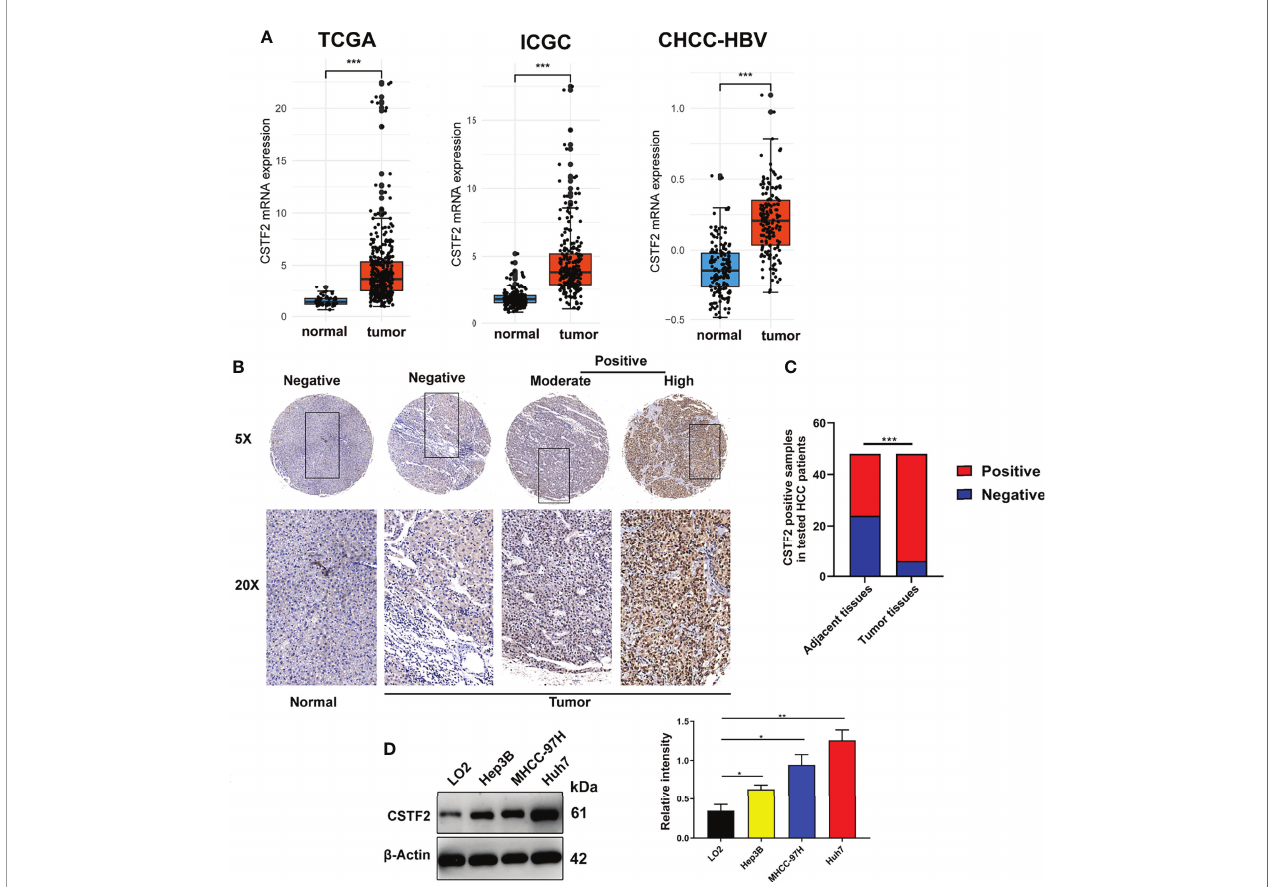
FIGURE 2 | CSTF2 is highly expressed in HCC. (A) Analysis of CSTF2 mRNA expression levels in TCGA, International Cancer Genome Consortium (ICGC), and Chinese patients with hepatitis B virus (CHCC-HBV) databases (B) Representative images of the immunohistochemistry staining of CSTF2 in hepatocellular carcinoma (HCC) and adjacent non-tumor tissues from different HCC patients (tumor indicates HCC tissue; normal indicates adjacent normal tissue). (C) Quantitative analysis of sample numbers in different CSTF2 expression levels in 48 pairs of HCC tissues. (D) Western blot analysis of CSTF2 protein levels in non-tumorigenic LO2 liver cells, hepatocellular carcinoma cell lines Huh7, MHCC-97H, and Hep3B (left panel) and quali fi cation of the relative intensity of CSTF2 protein levels (right panel). The levels of b -actin were used as an internal control. ** r < 0.01, *** r <